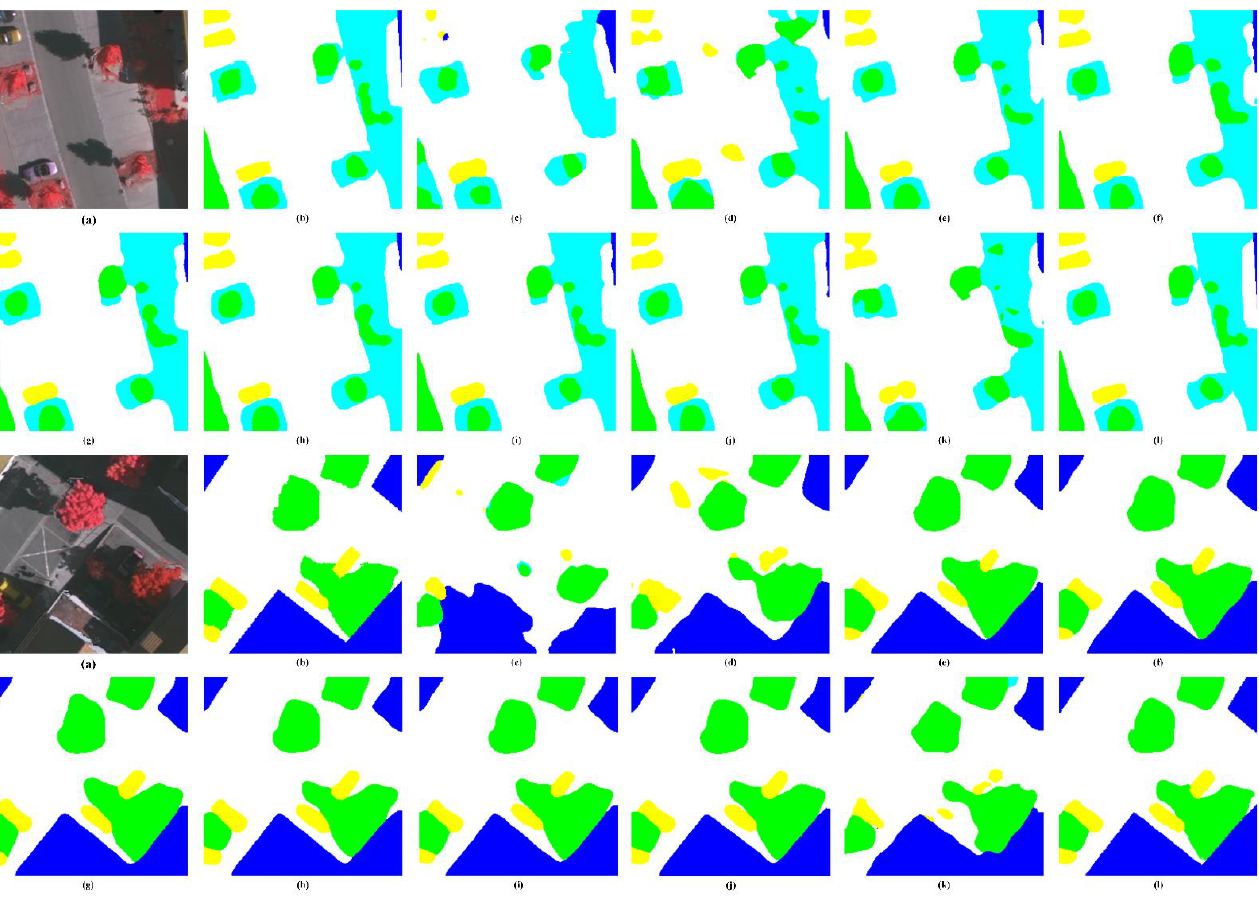
Figure 7. Visual inspections of random samples from Vaihingen test set. ( a ) raw image, ( b ) ground truth, ( c ) SegNet, ( d ) U-Net, ( e ) DeepLab V3+, ( f ) CBAM, ( g ) DANet, ( h ) NLNet, ( i ) OCRNet, ( j ) ResUNet-a, ( k ) SCAttNet, ( l ) EDENet.